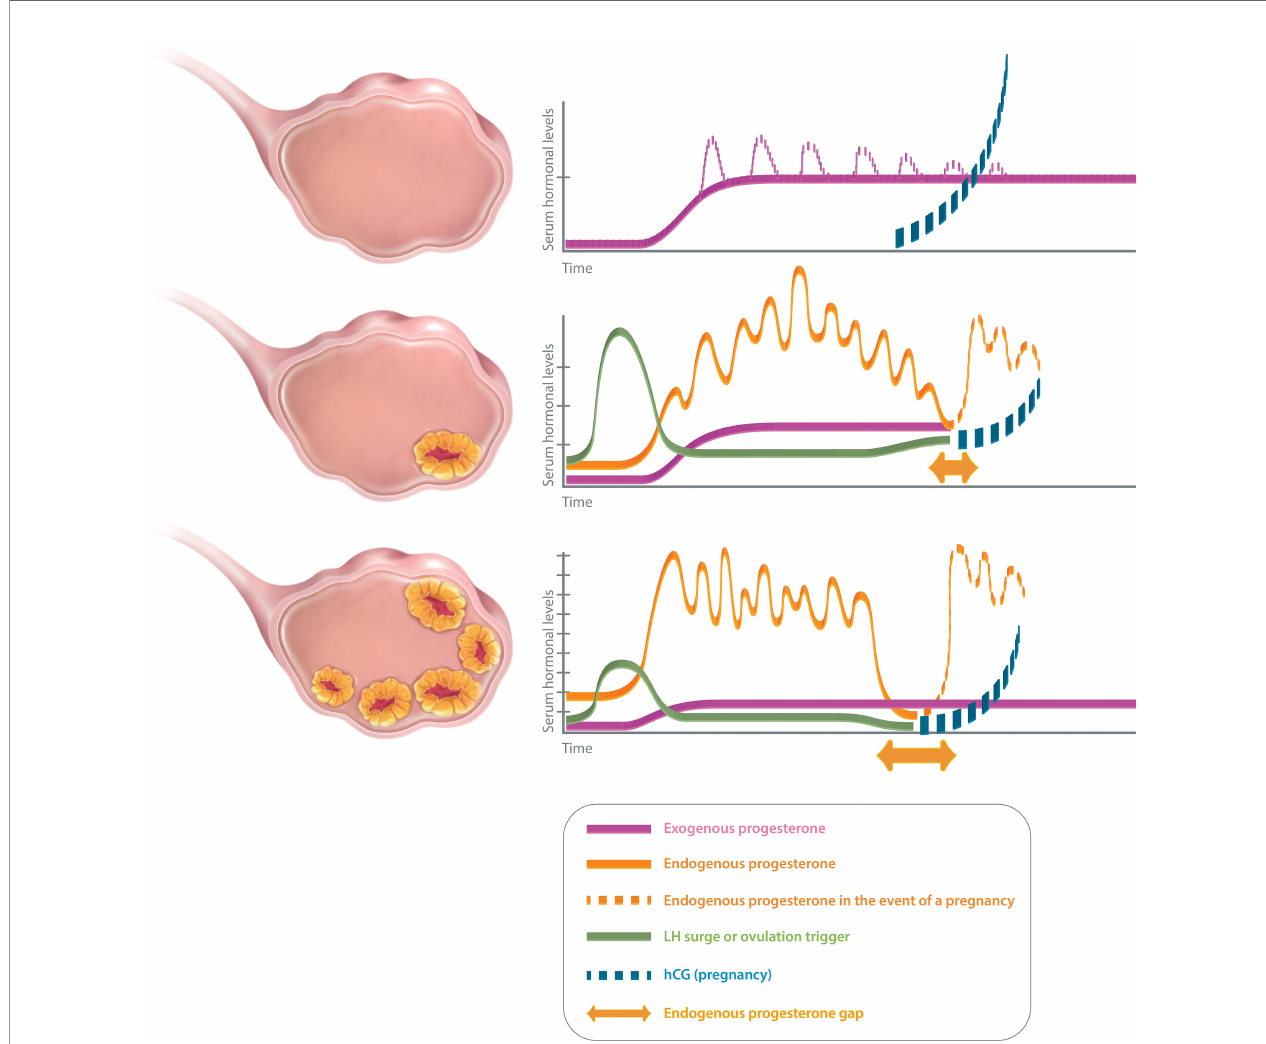
FIGURE 1 | Luteal phase scenarios in ART. No corpus luteum (upper panel): arti fi cial cycle (HRT). Progesterone only emanates from the luteal support (exogenous progesterone). Serum progesterone level quickly reaches a plateau (estimated serum progesterone level with vaginal progesterone: 10 – 15 mg/ml), except for injected progesterone for which peaks are observed initially (dotted line). Serum progesterone level is not modi fi ed in the event of a pregnancy as hCG does not interfere with the exogenous progesterone. One or few corpora lutea (middle panel): after ovulation trigger, endogenous progesterone secretion is pulsatile and varies during the day (estimated serum progesterone level: 25 – 35 mg/ml). There might be a small endogenous progesterone gap (mainly in cycles with few CL, in between a possible luteal insuf fi ciency and the taking over of the hCG from the pregnancy). Luteal support is indicated to cover that gap. Several corpora lutea (lower panel): after ovulation trigger, endogenous progesterone secretion is pulsatile and varies during the day (estimated serum progesterone level: about 40 – 80 mg/ml, but might vary according to the number of CL). There will be a large endogenous progesterone gap (in between the iatrogenic luteal insuf fi ciency and the taking over. Luteal support is indicated to cover that